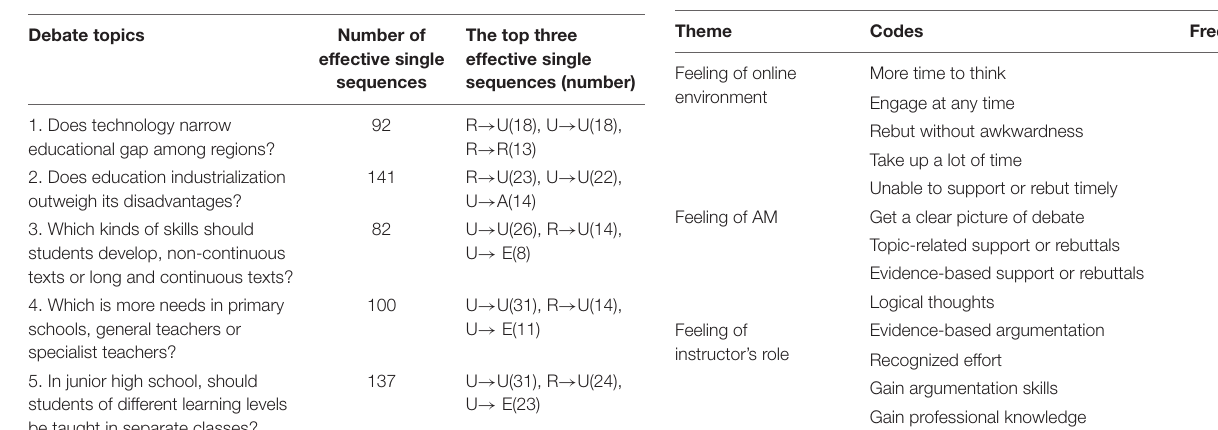
TABLE 9 | Codes and frequencies of the semi-structured interview